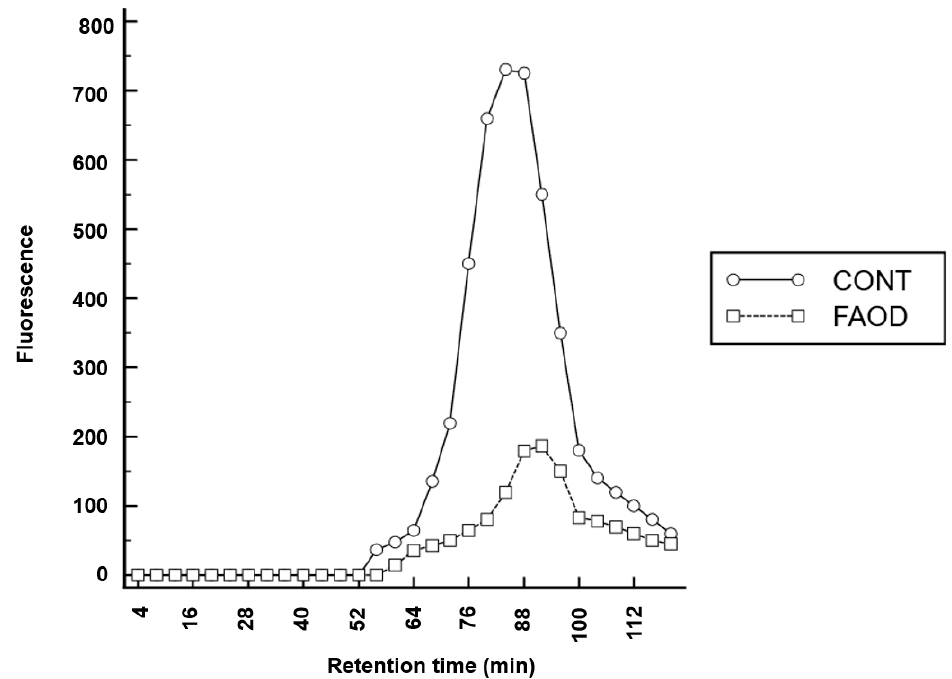
Figure 4. Auto-fluorescence of human lenses following FAOD treatment. Figure 4. Auto- fl uorescence of human lenses following FAOD treatment.